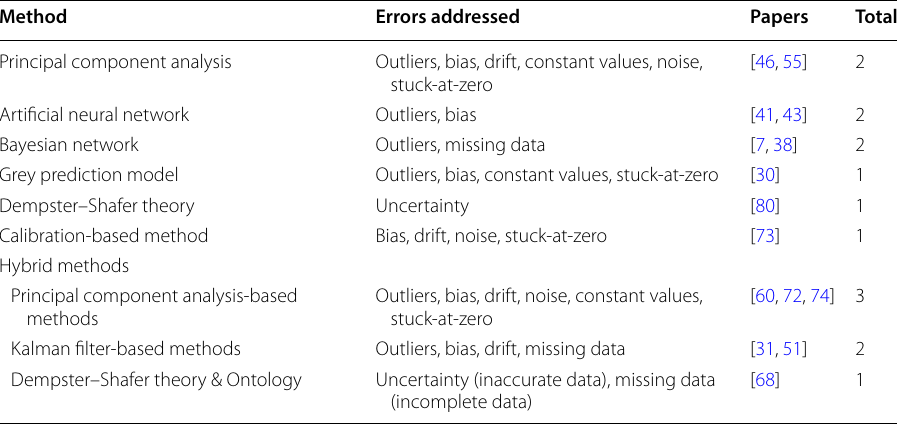
Table 5 Methods combining error detection and correction (RQ2 and RQ3), along with its addressed errors, respective papers, and the total number of papers that proposed that